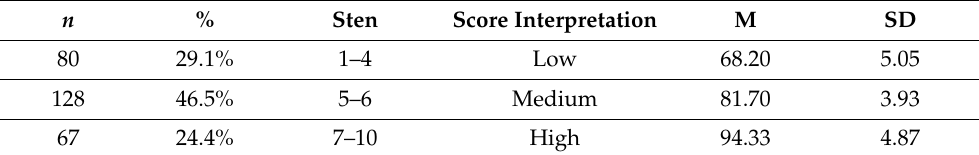
Table 3. Participant HBI scores according to sten norms.